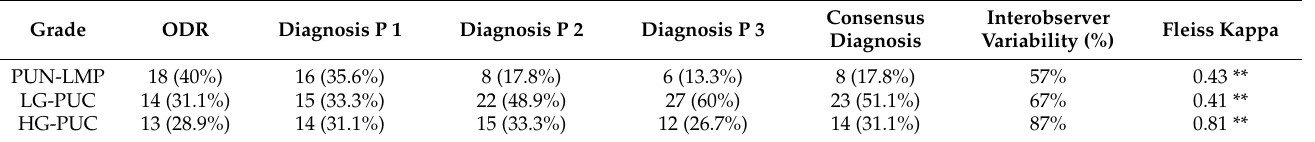
Table 2. Interobserver variability among the histological categories of the WHO 2004/2016.